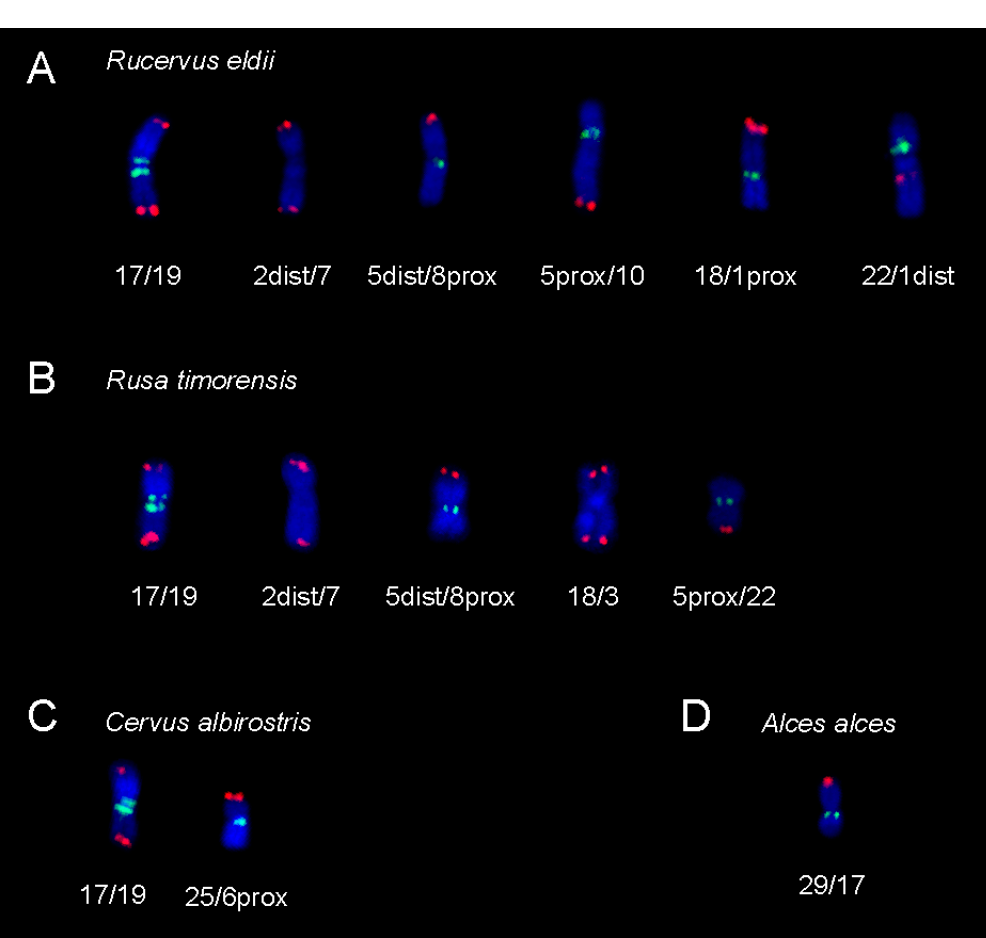
Figure 6. Centromere-telomere orientation of the fused chromosomes in ( A ) R. eldii , ( B ) R. timorensis , ( C ) C. albirostris and ( D ) A. alces . Green signal—proximal BAC probe; red signal—distal BAC probe.